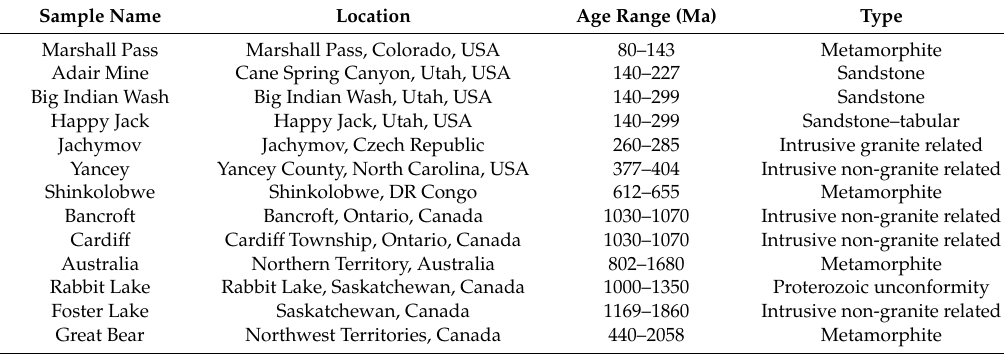
Table 1. Sample location, published age range, and associated International Atomic Energy